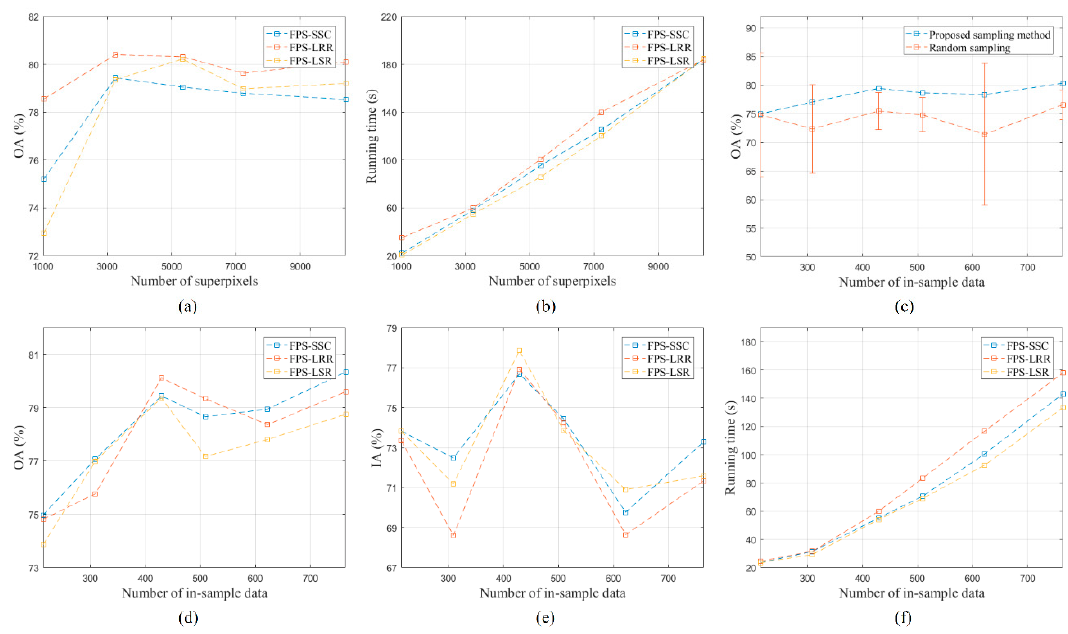
Figure 7. Analysis of the number of superpixels and the selection of in-sample data: ( a ) change in overall accuracy (OA) with various numbers of superpixels; ( b ) change in running time with various numbers of superpixels; ( c ) comparison between random sampling and proposed method; ( d ) change in OA with various numbers of in-sample data; ( e ) change in In-sample Accuracy (IA) with various numbers of in-sample data; ( f ) change in running time with various numbers of in-sample data.